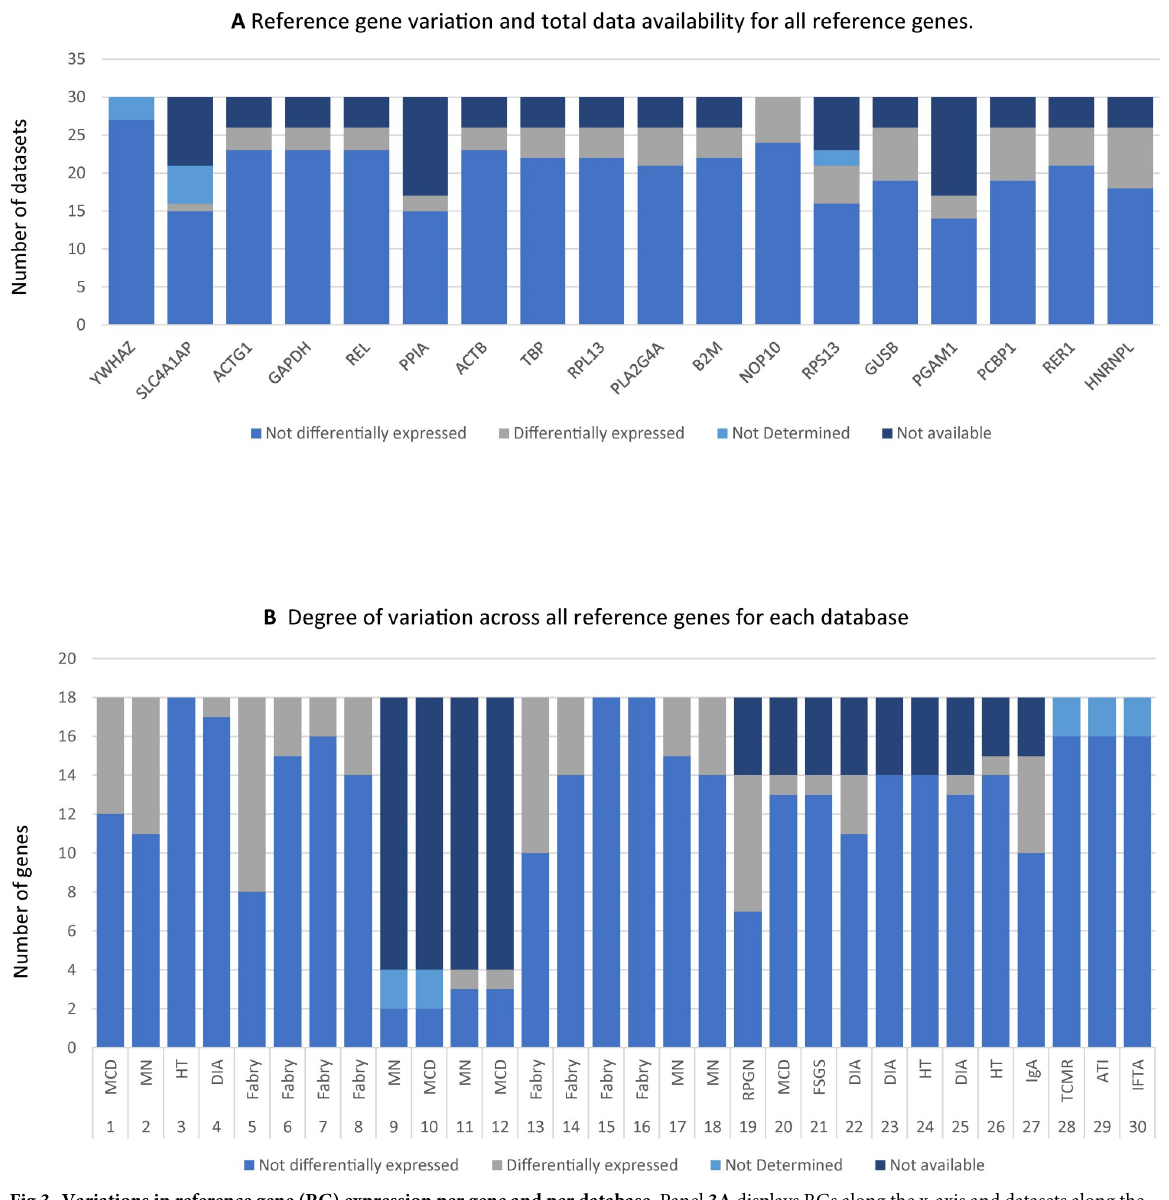
Fig 3. Variations in reference gene (RG) expression per gene and per database. Panel 3A displays RGs along the x-axis and datasets along the y-axis. For each RG the number of datasets where the RG was either not detected, not available, differentially expressed or not differentially expressed is marked. Not available (NA) refers to RGs not tested in specific datasets. Not detected (ND) refers to genes undetected in the specific dataset. If a particular variable is not listed its value was zero, such as e.g., the number of datasets were YWHAZ was differentially expressed is not listed, since YWHAZ was stable in all datasets. Panel 3B displays Datasets along the x-axis and RGs on the y-axis. For each database how many RGs were either not detected, not available, differentially expressed or not differentially expressed is marked. Characteristics of each database are described in detail on Table 1